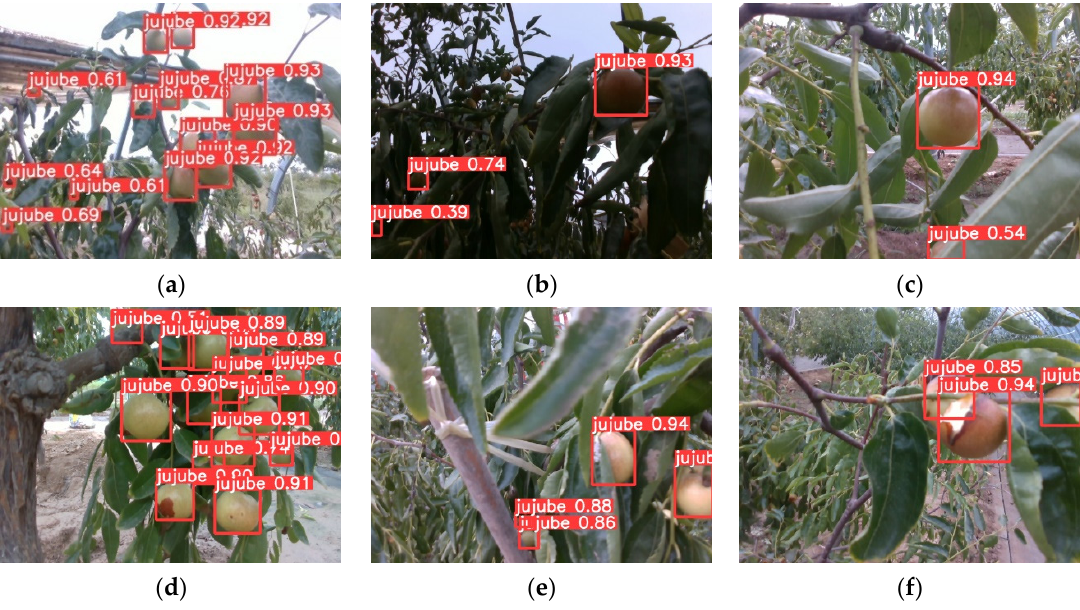
Figure 13. Test results of different scenes. ( a ) Bright light; ( b ) Dim light; ( c ) Single target; ( d ) Multiple targets; ( e ) Shading by branch and leaves; ( f ) Broken Fruit.